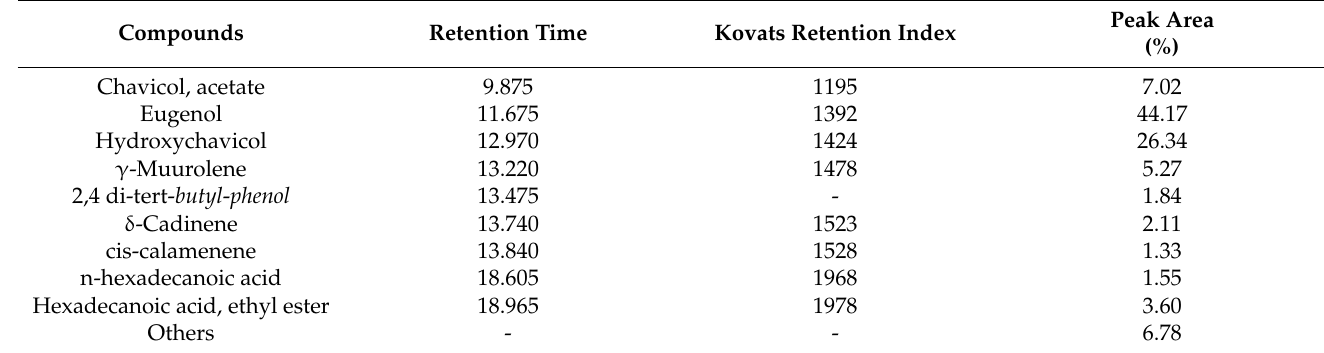
Table 2. Phytochemical composition of Piper betle ethanolic leaf